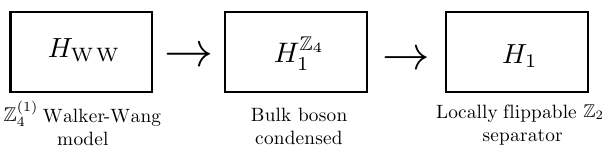
FIG. 1. The construction of the locally flippable Z 2 separa- tor H 1 begins with a Walker-Wang model H WW based on the Z ( 1 ) premodular anyon theory (Sec. II A). Model H WW has an 4 order-two bulk boson, which, when condensed, produces the Z 4 Pauli stabilizer model H defined on four-dimensional qudits 1 (Sec. II B). Hamiltonian H 1 is then obtained by mapping each four-dimensional qudit to a pair of qubits, applying a FDQC composed of controlled- NOT ( CNOT ) gates, and projecting into a particular subspace (Sec. II C). Hamiltonian H 1 is a locally flippable separator and defines QCA α 1